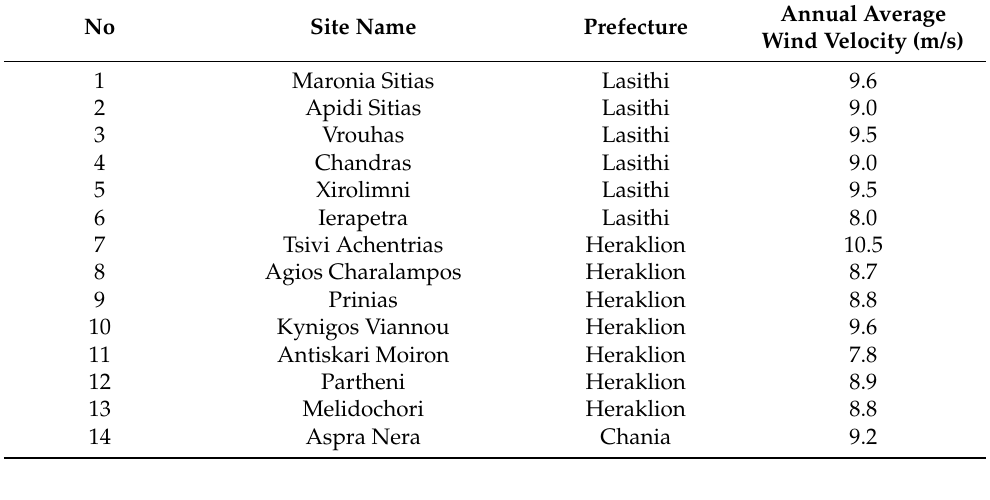
Table 9. Wind measurement sites and the annual average wind velocity.